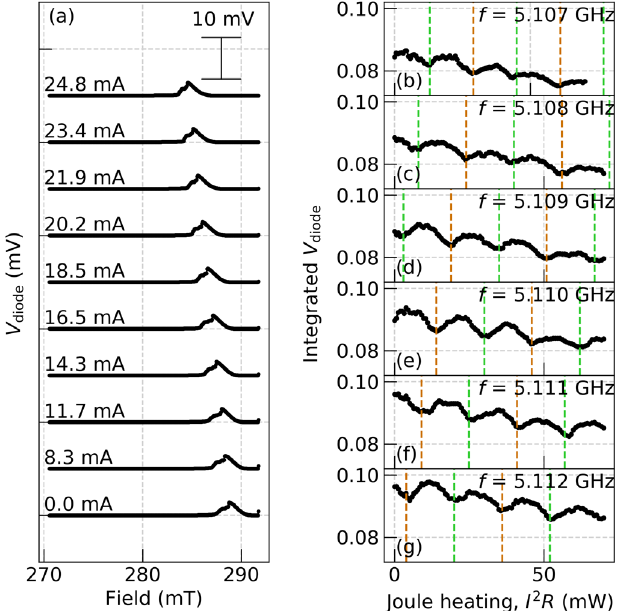
FIG. 7. (a) The diode absorption voltage V measured diode simultaneously with V during the temperature-tuning experi- ISHE ment. Data are shown for f ¼ 5 . 11 GHz with different current values. (b) – (g) Integrated V as a function of Joule heating for diode different frequencies. The green and dark orange lines represent the odd and even phonons, respectively.